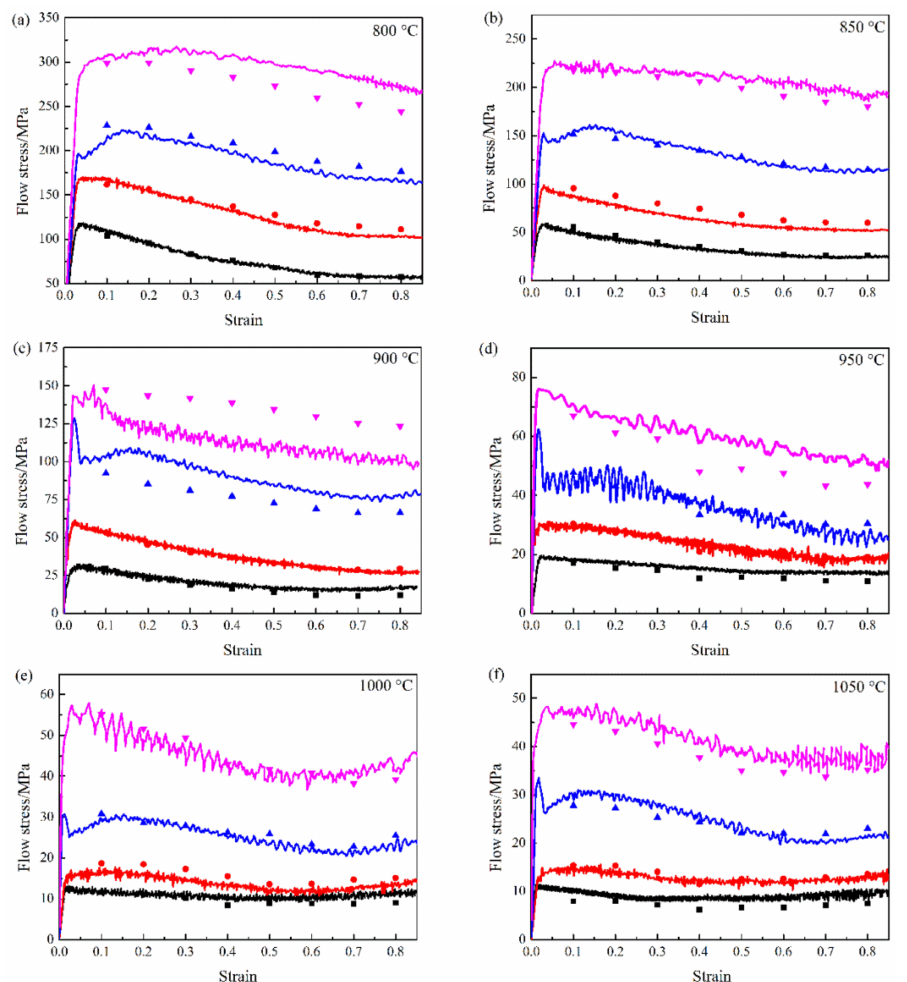
Figure 13. Comparison between the experimental (solid lines) and predicted (dots) flow stress at the temperature of ( a ) 800 ◦ C; ( b ) 850 ◦ C; ( c ) 900 ◦ C; ( d ) 950 ◦ C; ( e ) 1000 ◦ C; ( f ) 1050 ◦